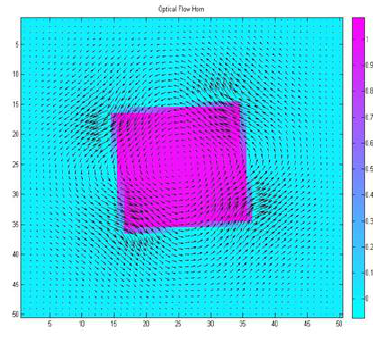
Figure 9. Results of Horn/Schumck (α=5)